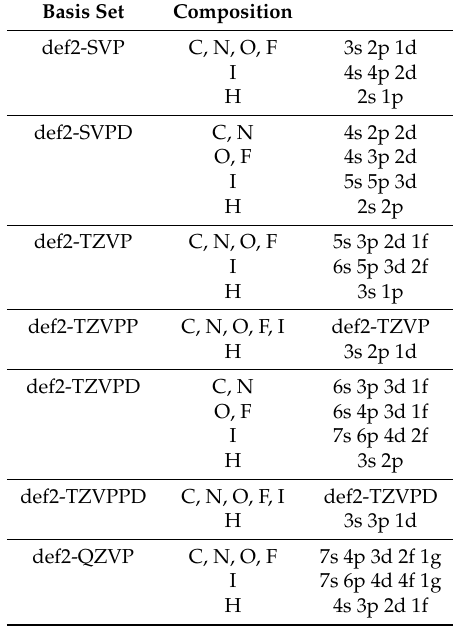
Table A2. Ahlrichs basis sets and their contracted compositions for the atoms in PYV3 · I2but.